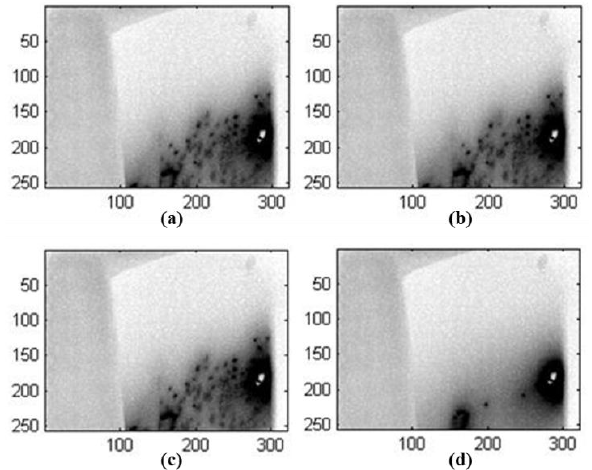
Figure 13. IR results with MWT for defect detection in glass fiber wind blade after 1 min microwave excitation with 0.915 GHz ( a ), after 2 min microwave excitation with 0.915 GHz ( b ), after 1 min microwave excitation with 2.45 GHz ( c ) and after 2 min microwave excitation with 2.45 GHz ( d ).